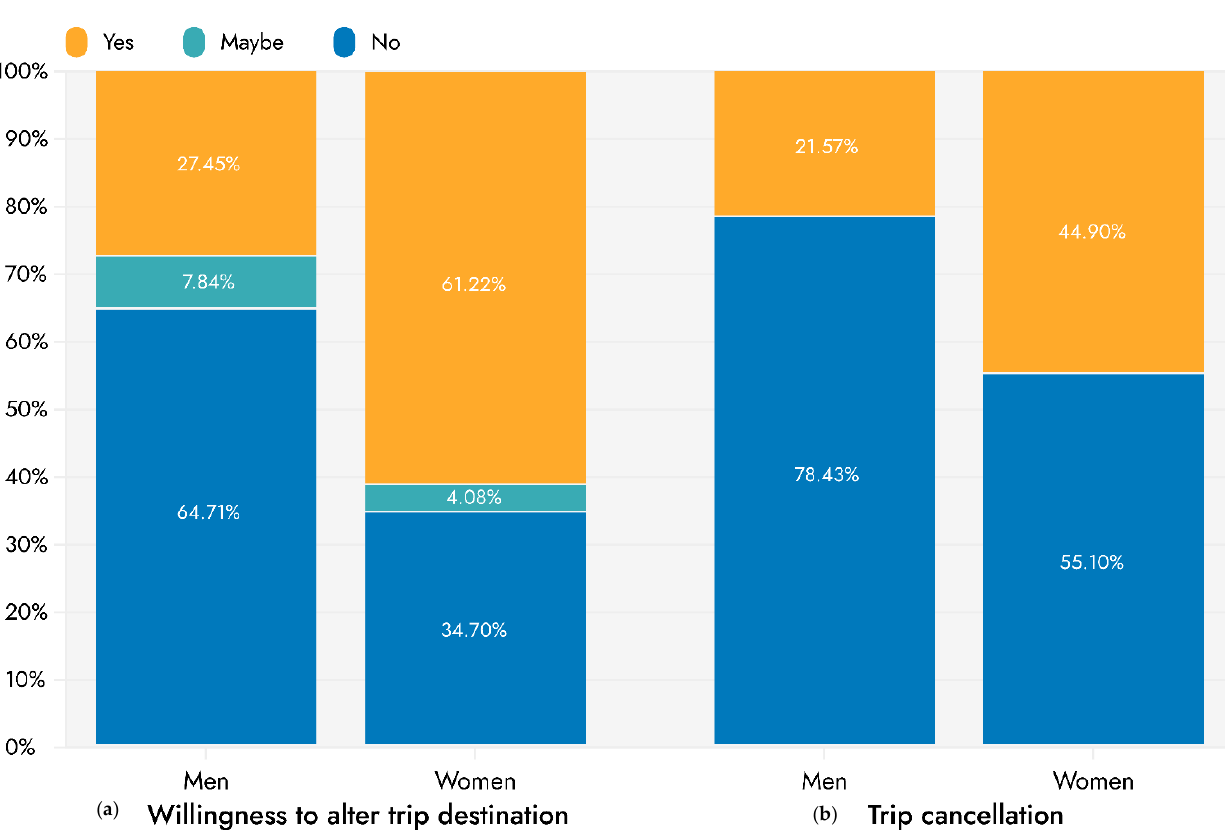
Figure 11. Bar chart presenting men’s and women’s responses regarding ( a ) the willingness to alter trip destination and ( b ) trip cancellation.